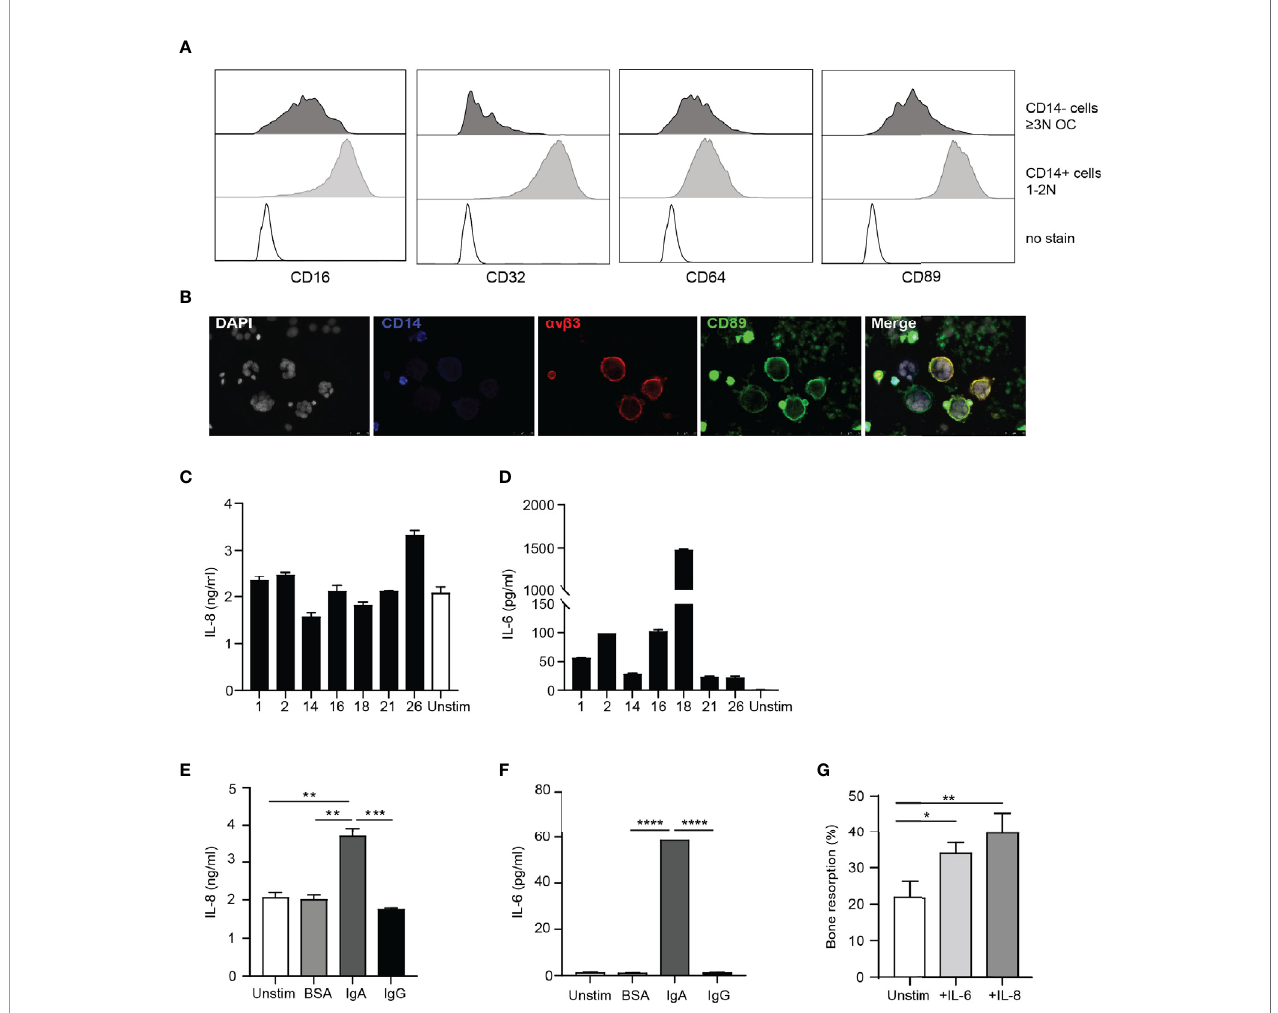
FIGURE 5 | Osteoclasts are activated by IgA immune complexes. (A) Expression of CD16, CD32, CD64 and CD89 on CD14 negative OCs (upper panels; dark grey histograms) and remaining CD14 + cells (middle panels; light grey histograms) compared to no stain (lower panels; dotted black line histograms). (B) CD89 expression on CD14 - a V b 3 + OCs. [White (DAPI) = nuclei, blue = CD14, red = a V b 3, green = CD89]. (C, D) IL-8 (C) and IL-6 (D) release by OCs stimulated with immune complexes isolated from synovial fl uid of RA patients. (E, F) IL-8 (E) and IL-6 (F) release by unstimulated OCs (white bar) and after stimulation with BSA- (light grey bar), IgA- (dark grey bar) or IgG- (black bar) coated beads. (G) Quanti fi cation of bone resorption by OCs in presence of M-CSF and RANK-L (unstim, white bar) and added cytokines IL-6 (25 ng/ml, light grey bar) or IL-8 (10 ng/ml, dark grey bar). Data was analyzed using one way ANOVA with Tukey post-hoc; * p ≤ 0.05; ** p ≤ 0.01; *** p ≤ 0.001; **** p ≤